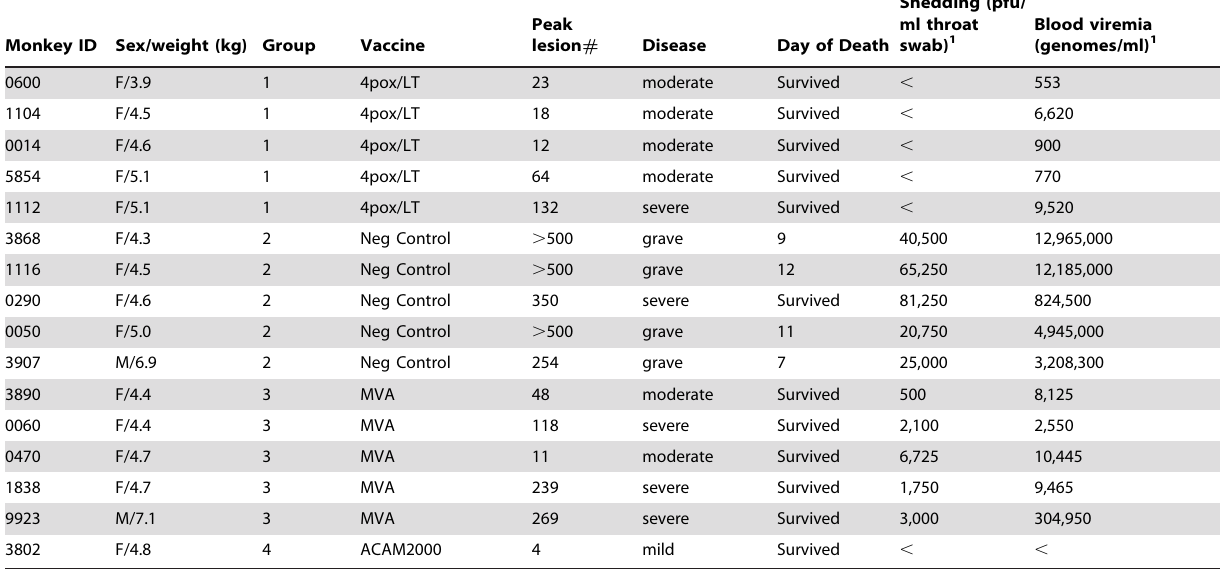
Monkey ID Sex/weight (kg)